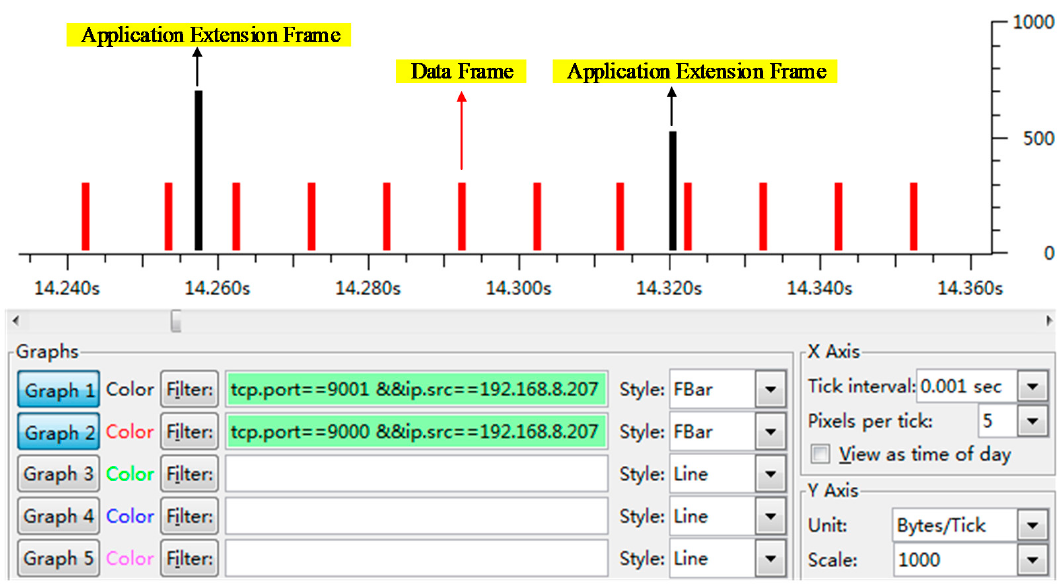
Figure 13. Data frames and application extension frames at a 1 ms time scale level.